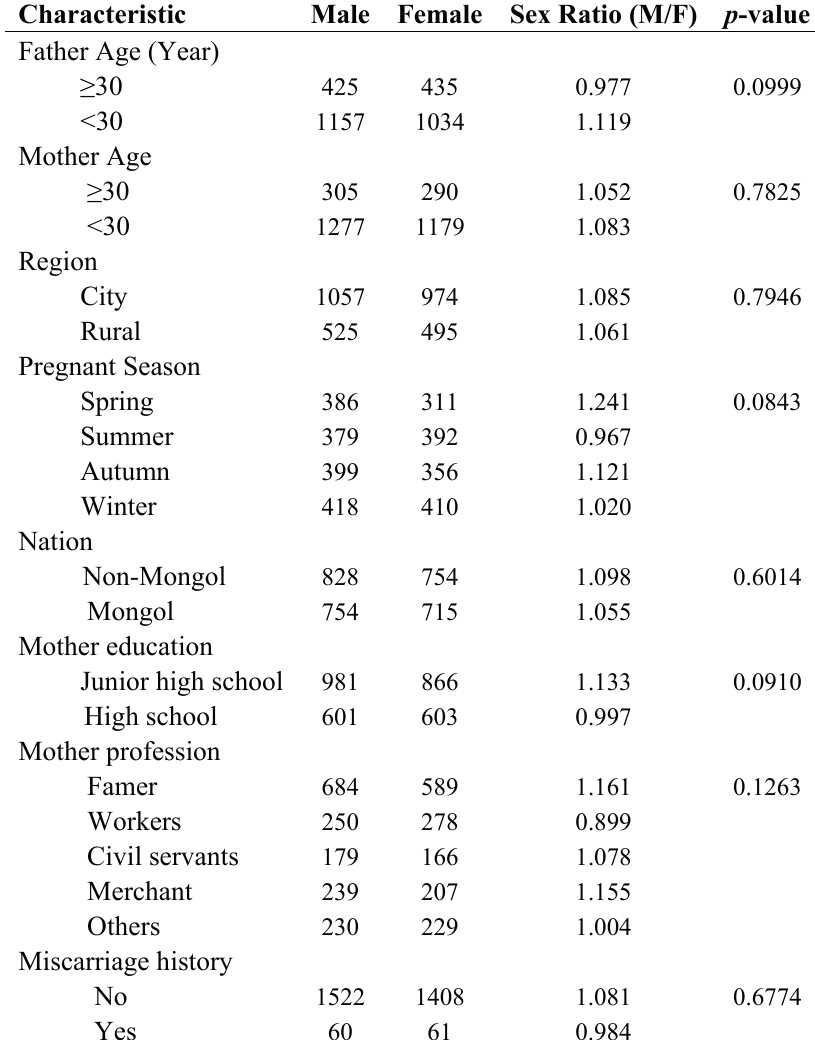
Table 1. Characteristics of the birth-sex.